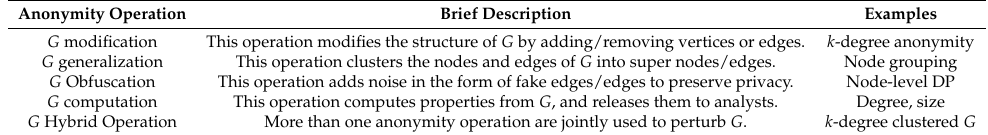
Table 2. Summary of anonymization operations that can be applied to G for privacy